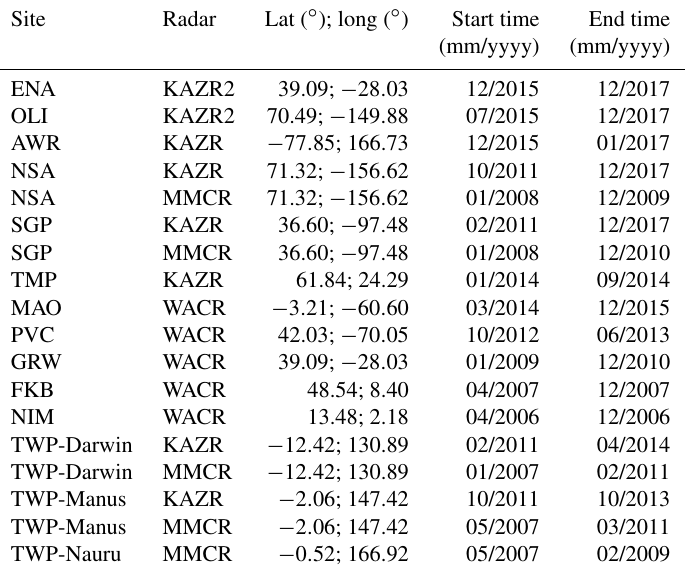
Table 1. Information on the sites (name and location), the type of radar, and the start and end dates of the calibration period. Site